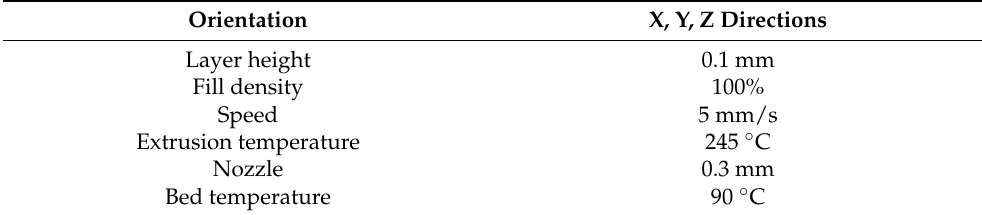
Table 1. Process parameters.